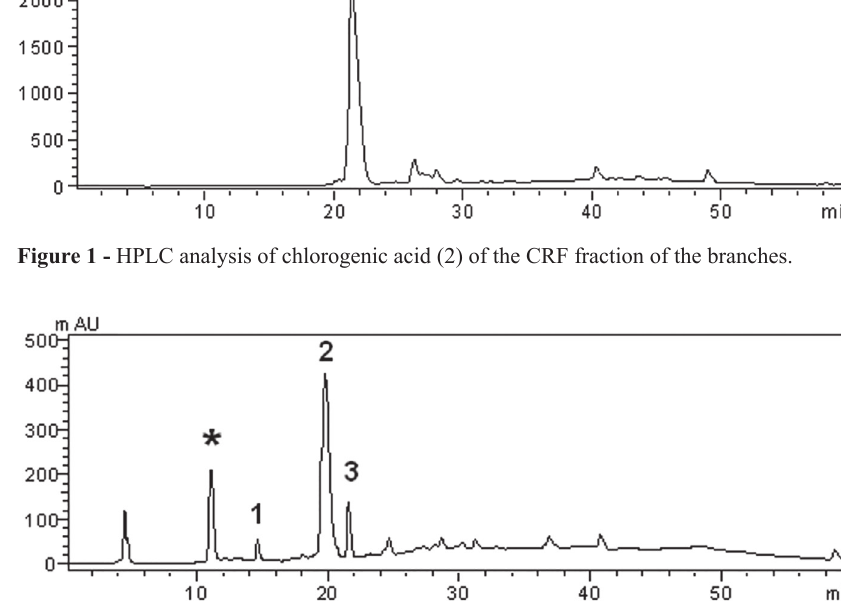
Figure 2 - HPLC analysis of gallic acid (1), chlorogenic acid (2), and caffeic acid (3) of the n-BuOH fraction of the branches, (*) unknown peak.